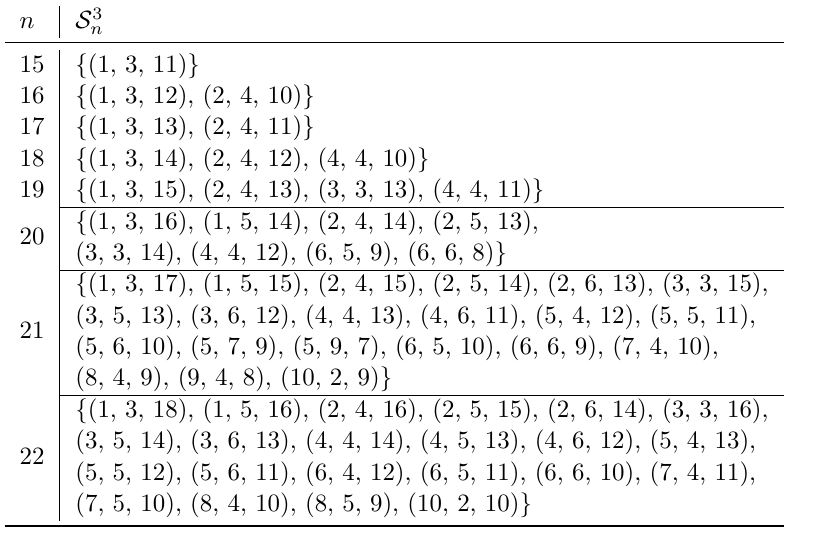
Table 3: All possible configurations of active Sboxes for 3-round trails for n = 15 , · · · , 22.